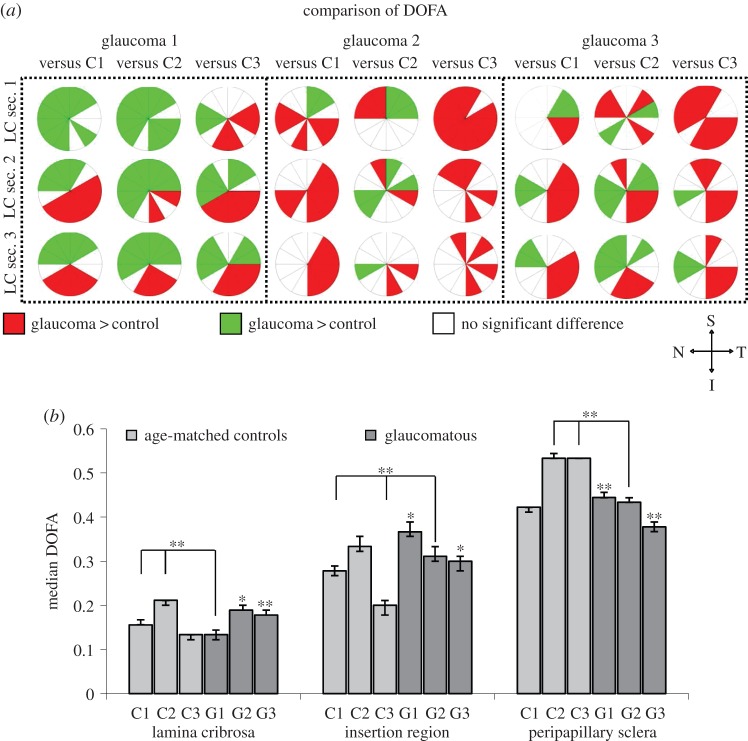
(a) Significant differences (p < 0.05) in DOFA between the three serial LC sections (anteriormost LC section 1 to LC section 3) from three glaucoma (G1, G2, G3) and three age-matched control (C1, C2, C3) LCs. Red: DOFA in glaucoma LC > control LC. Green: DOFA in glaucoma LC < control LC. White: no significant difference between glaucoma and control LC DOFA. Bonferroni adjusted significant differences were determined using the independent samples t-test or Mann–Whitney U-test. Note the orientation of LC sections, i.e. S, superior; N, nasal; I, inferior; T, temporal. (b) Comparison of median DOFAs (±95% CIs) in the LC, insertion region and ppsclera of glaucoma (G1, G2, G3, dark grey) and age-matched control (C1, C2, C3, light grey) ONHs. Unless the comparison is specified, significant differences (*p < 0.017, **p < 0.0033) in DOFA were found between the designated glaucoma LC and all control LCs. Bonferroni adjusted significant differences were determined using the Mann–Whitney U-test.